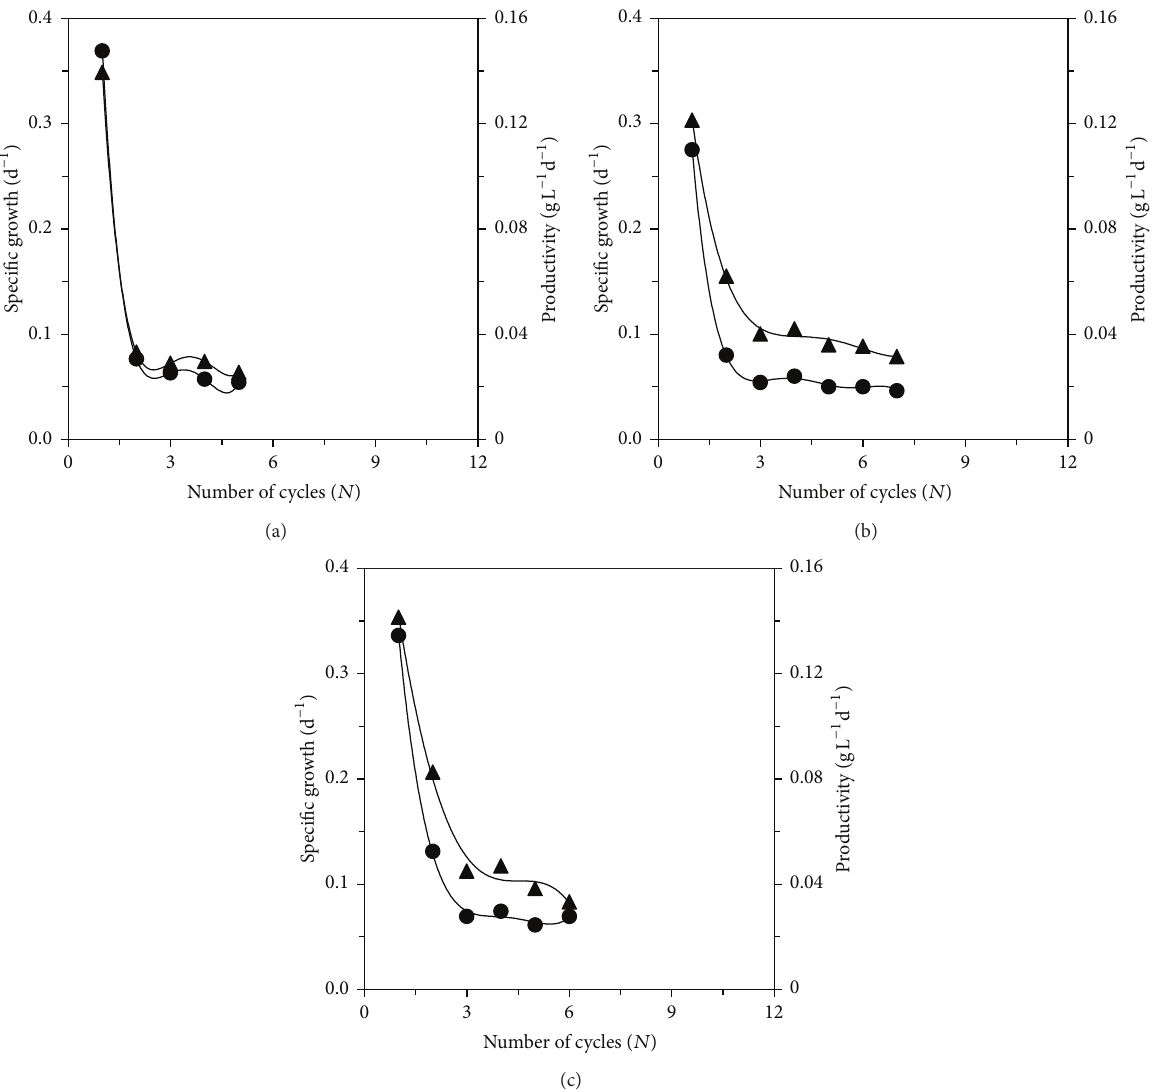
Figure 2: Evolution of the specific growth rate ( e ) and productivity ( 󳵳 ) as a function of number of cycles for (a) blend concentration of 0.60 g L −1 , medium renewal rate of 40%, and sodium bicarbonate concentration of 0.40 g L −1 (experiment 6); (b) blend concentration of 0.80 g L −1 , medium renewal rate of 30%, and sodium bicarbonate concentration of 0.40 gL −1 (experiment 9); and (c) blend concentration of 0.80 g L −1 , medium renewal rate of 50%, and sodium bicarbonate concentration of 0.40 gL −1 (experiment